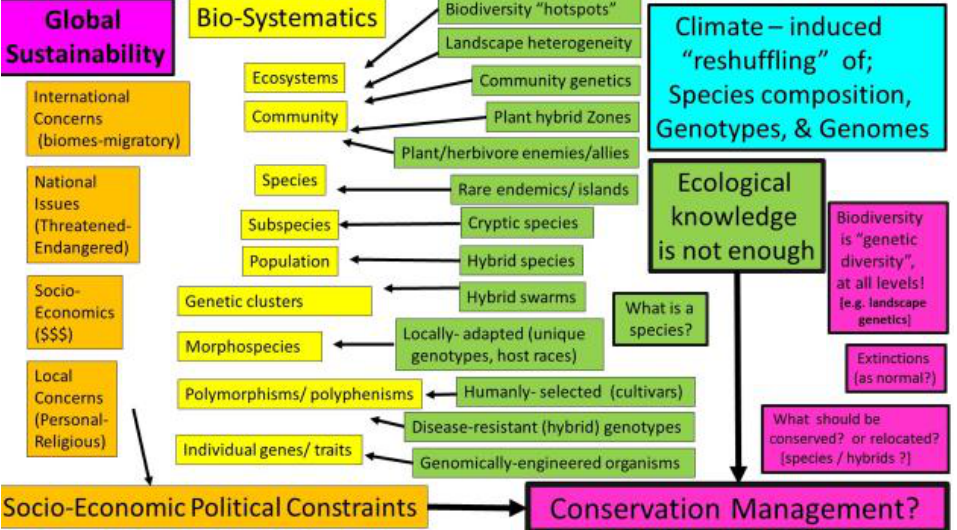
Figure 1. Some structural and functional aspects of insect conservation and diversity. Unsettled academic issues about bio-systematics persist (e.g., what is a species?), yet we know a tremendous amount about biodiversity genomes and genotypes to interspecific hybrid zones and community-level trophic interactions that determine distribution limits, abundance, and latitudinal diversity across global ecosystems. This review addresses some biological issues and impacts of climate- (cid:76)(cid:81)(cid:71)(cid:88)(cid:70)(cid:72)(cid:71)(cid:3)(cid:179)(cid:85)(cid:72)(cid:86)(cid:75)(cid:88)(cid:73)(cid:73)(cid:79)(cid:76)(cid:81)(cid:74)(cid:180)(cid:3)(cid:11)(cid:85)(cid:72)(cid:70)(cid:82)(cid:80)(cid:69)(cid:76)(cid:81)(cid:68)(cid:87)(cid:76)(cid:82)(cid:81)(cid:12)(cid:3)(cid:82)(cid:73)(cid:3)(cid:86)(cid:83)(cid:72)(cid:70)(cid:76)(cid:72)(cid:86)(cid:3) composition, genotypes, and genomes. However, future conservation management programs will not be constrained by our capacity for ecological/evolutionary predictions, but rather by our own human behavior. Ecologists and conservation managers need to work more closely with sociologists, economists, politicians and religious groups if we want a more sustainable world.